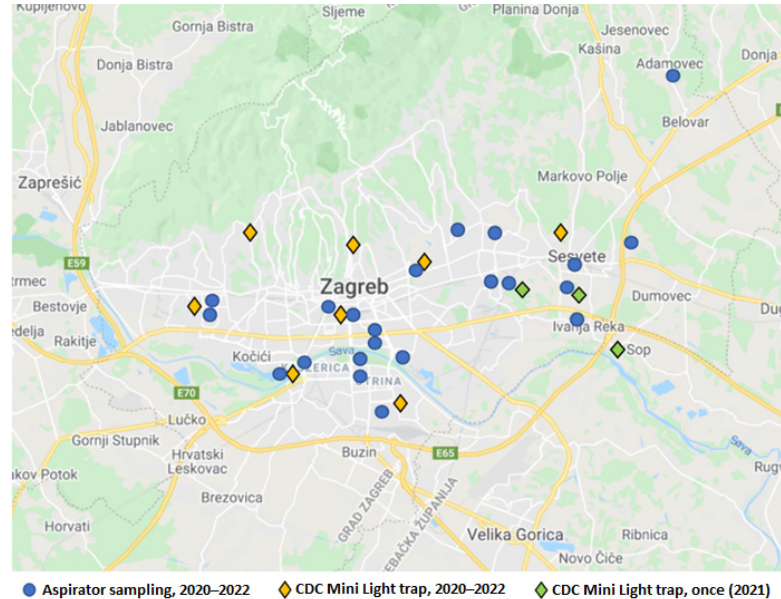
Figure 2. Distribution of mosquito sampling locations.